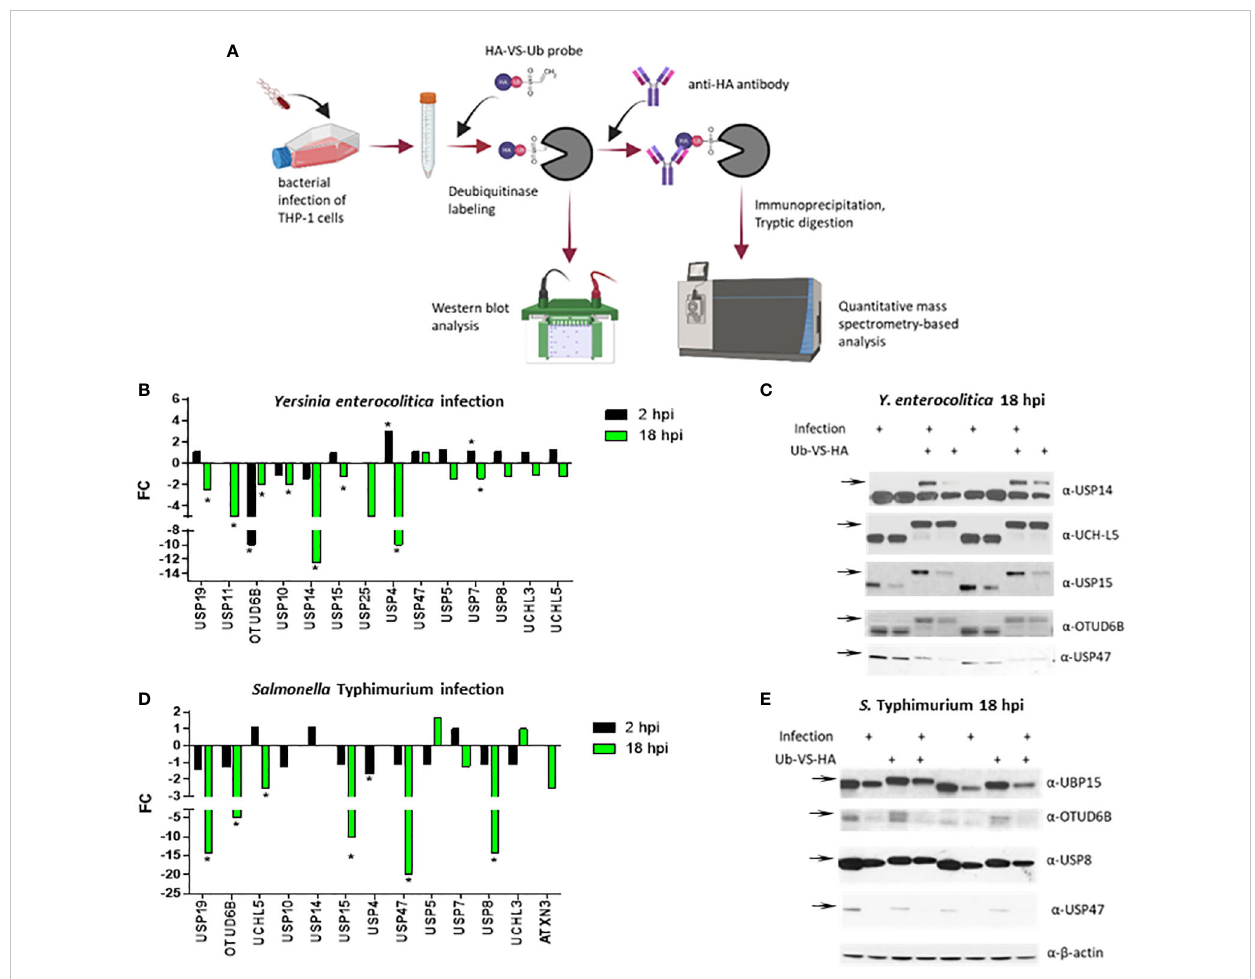
FIGURE 1 Activity-based labeling of DUBs in Y. enterocolitica or S. Typhimurium infection of human macrophages. Combining active site-directed probes and quantitative proteomics to identify changes in the DUB activity and (or) abundance in THP-1 cells (A) infected with Y. enterocolitica (B, C) or S. Typhimurium (D, E) or for 2 or 18 hours. (A) An overall strategy to label deubiquitinases in infected macrophages. Cells were left uninfected or infected with the bacteria indicated below and collected after each time point of infection. The cells were lysed to extract proteins, which was followed by the labeling of active deubiquitinases with ubiquitin-speci fi c active site-directed probes (Ub-VS-HA). The probe-containing deubiquitinases were puri fi ed by anti-HA immunoprecipitation, and either visualized by using SDS-PAGE and western blotting or subjected to proteomics analysis to quantify the probe-bound deubiquitinases. The number of independent replicates for this experiment was 3 (n=3). (B, D) . The quanti fi cation of active DUBs in Y. enterocolitica or S. Typhimurium infection using proteomics. After mass spectrometric analysis of immunopuri fi ed deubiqutinases, the fold change differences between infected and uninfected cells were calculated from each protein ’ s total weighted spectral counts. The statistical analysis was done using Fisher ’ s test. The number of independent replicates for this experiment was 3 (n=3). (C, E) . The con fi rmation of protein abundance and activity of deubiquitinases by western blotting of the samples containing Ub-VS-HA probe labeling. The experiment described above was repeated, but instead of immunopuri fi cation, crude lysates (control samples containing no Ub-VS-HA labeling), and probe-reacted deubiquitinases (shown by increased molecular weight upon Ub-VS-HA binding) were visualized by using western blotting. The number of independent replicates for this experiment was 3 (n=3). Biological duplicates are shown as analyzed by western blot. P-values were indicated: * p ≤